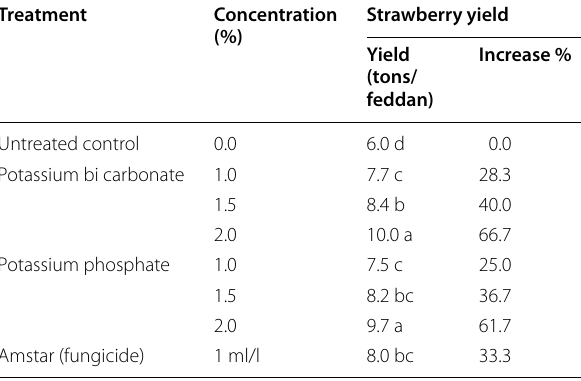
Values with the same letter(s) are not significantly different ( P